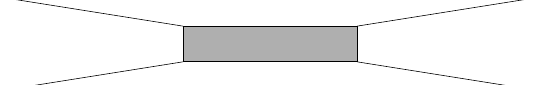
Figure 7: The peripheral direction relation embedding space [49], dropping a line from each corner of a rectangle toward the rest of the space at an arbitrary